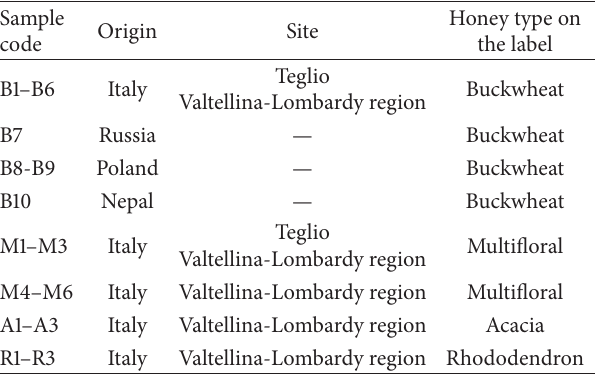
Table 1: List of samples. Codes, locations, and honey type reported on the commercial